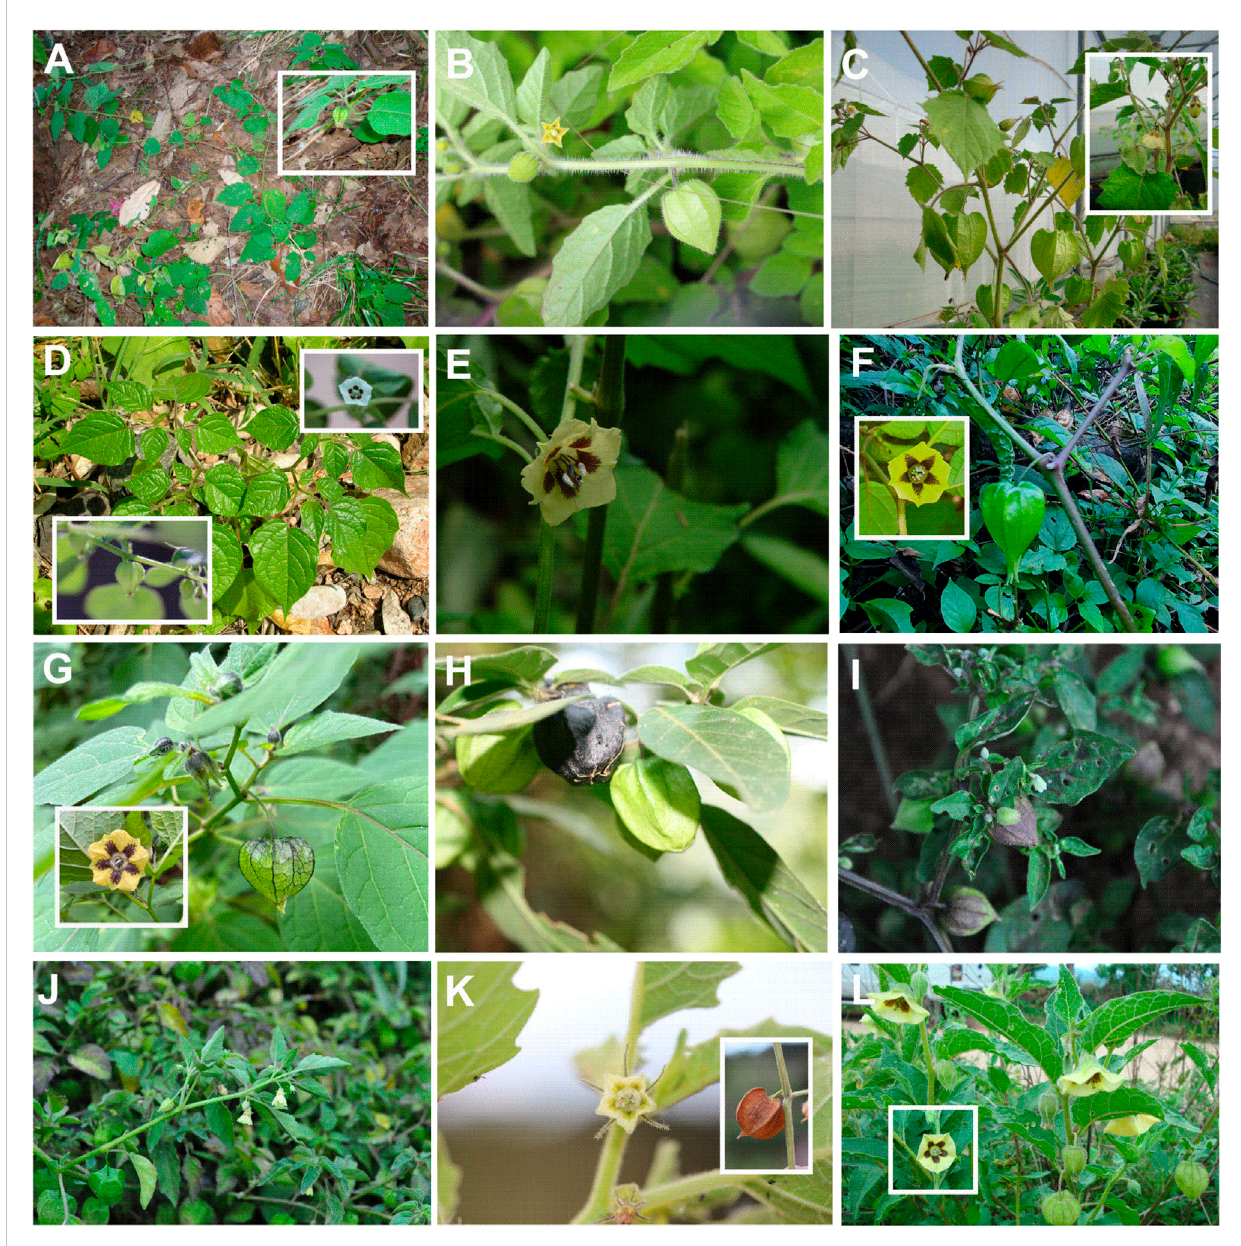
Details of fl owers and fruits of Physalis spp. (A) P. hintonii , (B) P. lagascae , (C) P. latiphysa , (D) P. leptophylla , (E) P. lignescens , (F) P. longiloba , (G) P. longipedicellata , (H) P. melanocystis , (I) P. microcarpa , (J) P. minuta , (K) P. nicandroides , (L) P.